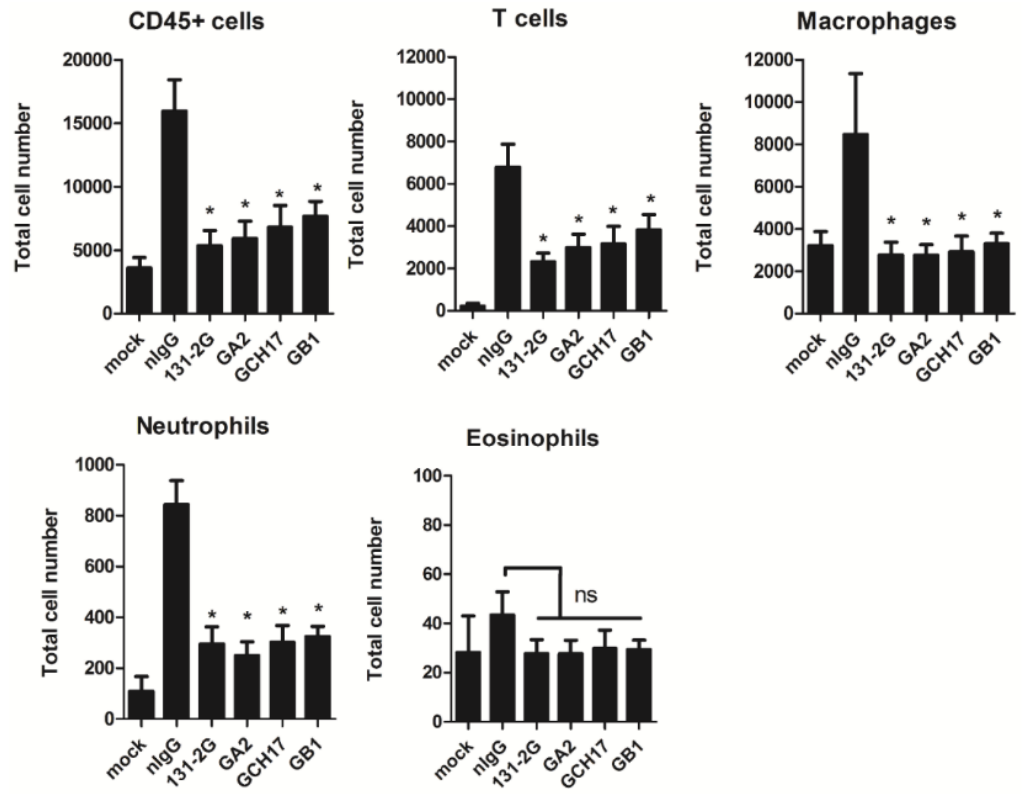
Figure 8. Pulmonary infiltration following therapeutic antibody treatment. BAL leukocytes (CD45 + cells), T cells (CD45 + CD3 + ), Macrophages (CD45 + SiglecF + CD11c + ), Neutrophils (CD45 + Gr1 + ) and Eosinophils (CD45 + SiglecF + CD11c-) numbers in the lungs of mice treated at day 2 and 4 p.i. with nIg, anti-RSV G mAb 131-2G or purified IgG from LbL nanoparticle were determined at day 5 p.i. Data shown are the means ± SEM. Asterisks indicate a significant difference ( p < 0.05) between nIgG-treated and antibody treated